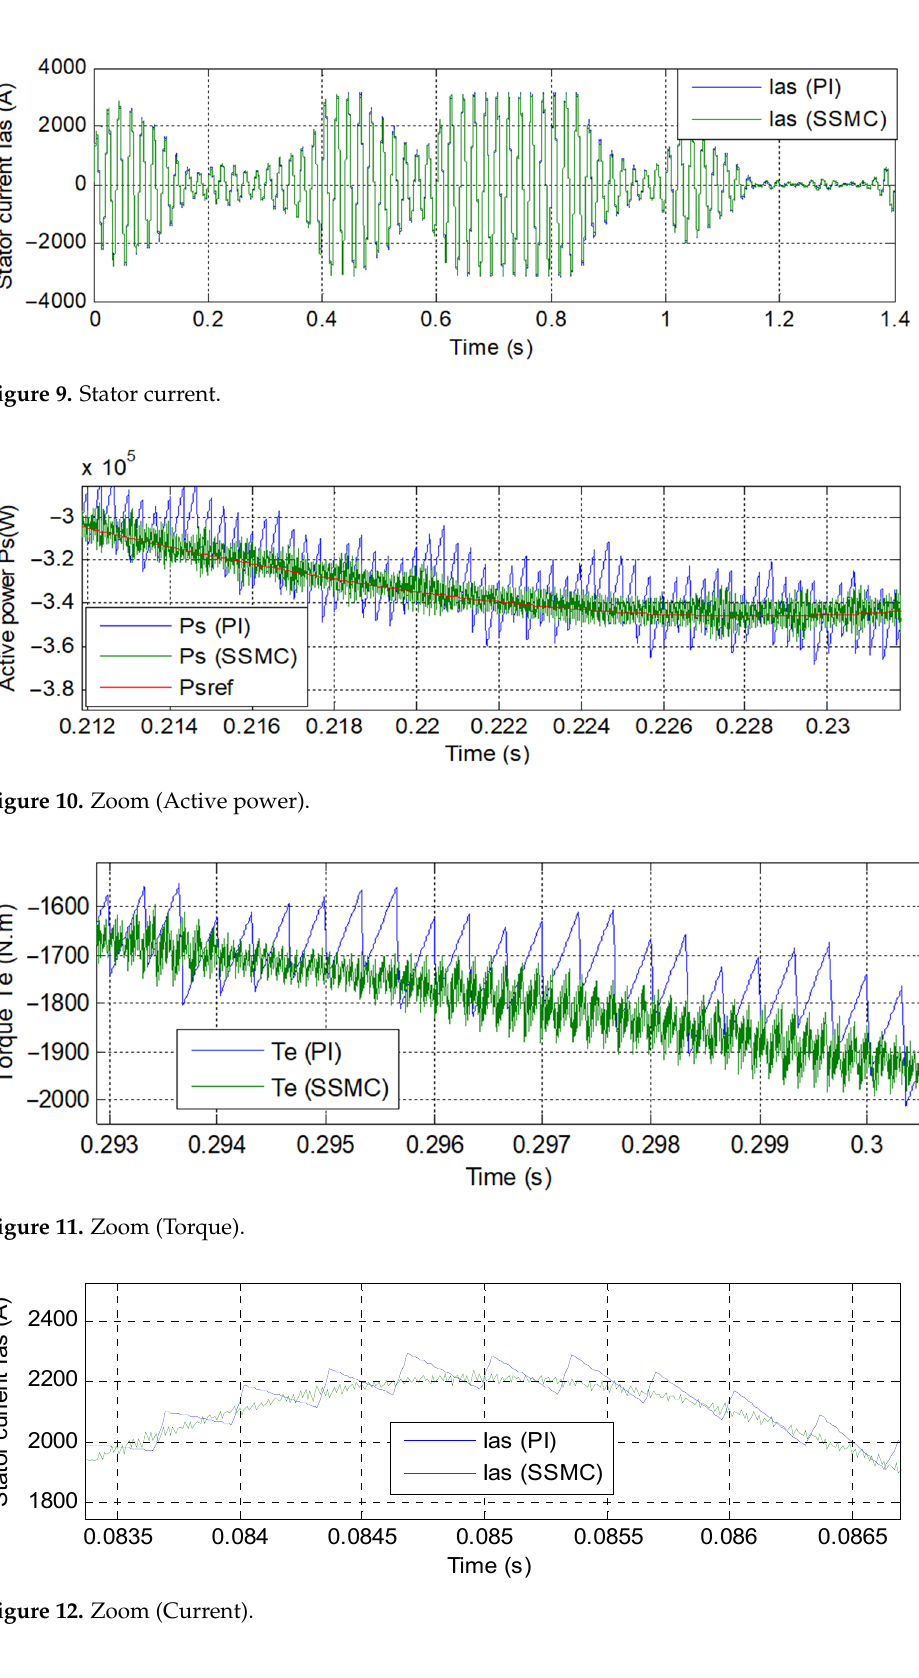
10 of 17 Figure 6. Active power. Figure 7. Reactive power.